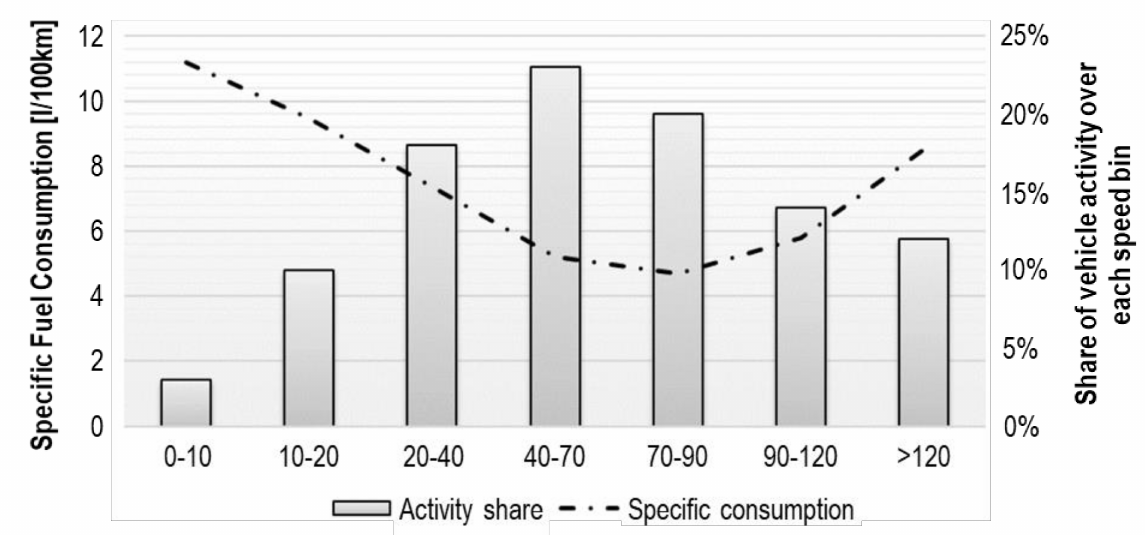
Figure 7. Speed-dependent fuel consumption and share of vehicle activity in [53] to show the dependency of overall fuel consumption on user specific transport